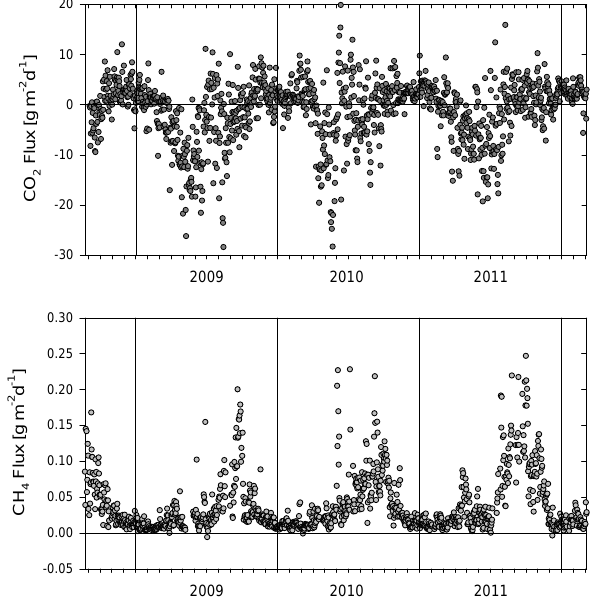
Fig. 1. Daily atmospheric fluxes of CO 2 (upper panel) and CH 4 (lower panel) over the first 3.5yr of measurements at Skjern Mead- ows. Upward fluxes are defined as